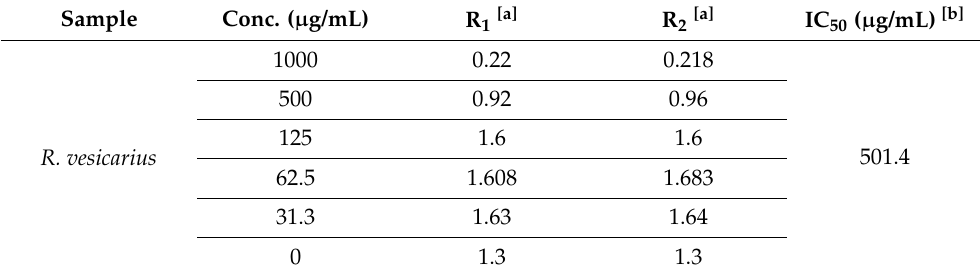
Table 4. Cytotoxic results of the extracted R. vesicarius on HepG2 cancer cell